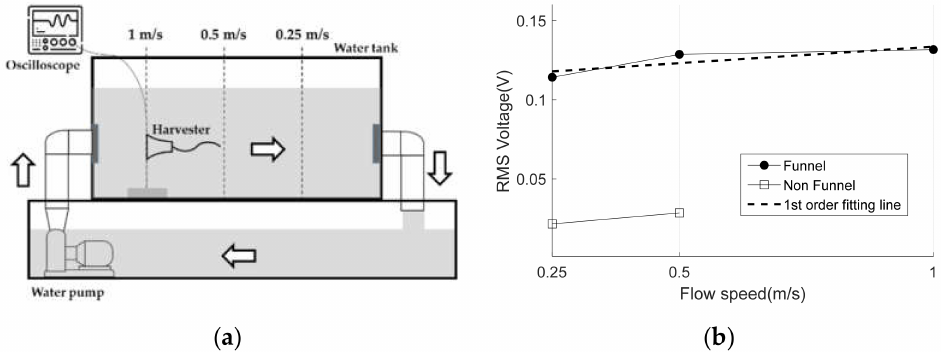
Figure 18. ( a ) Schematics of measurement setup; ( b ) RMS voltages according to flow speed.